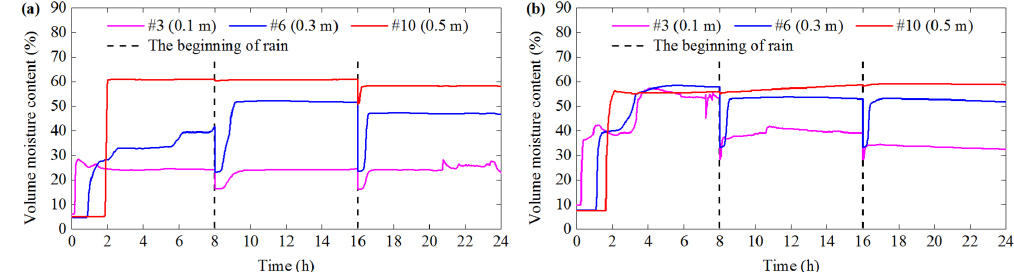
Figure 6. Volume moisture content at position C of (a) test 1 and (b) test 2.